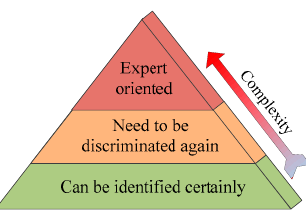
Figure 5. Basic idea underlying the comprehensive ship discrimination.